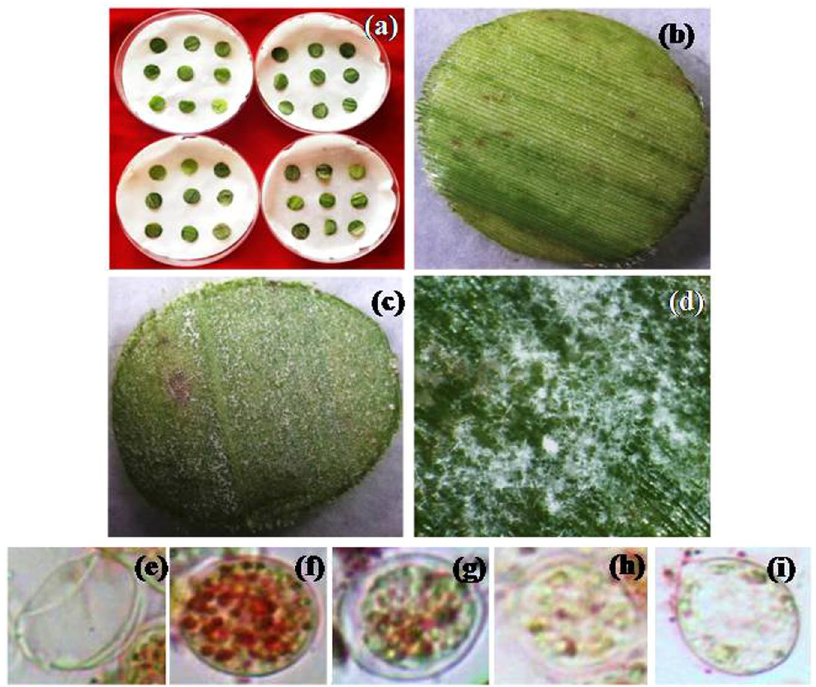
Figure 3. Anti-mildew activity. ( a ) Set up showing anti-mildew activity assay. ( b ) T.as-CF-SeNPs treatment suppressed the growth and sporulation of Sclerosporagraminicola . ( c ) Untreated infected leaf showing profuse sporulation of Sclerospora graminicola . ( d ) Close up view of infected leaf showing sporangia and sporangiospores, observed under stereo binocular microscope. ( e – i ) Viable and non-viable zoospores observed under microscope after TTC staining. ( e ) Empty sporangia after releasing viable zoospores (control), ( f ). Deeply red colored zoospores in sporangia (control), ( g ). T.ha-CF-SeNPs treatment showing mixture of live and dead zoospores, ( h ) and ( i ) zoospores showing reduction in viability of zoospores in T.br-CF-SeNPs and T.as-CF- SeNPs treatment,